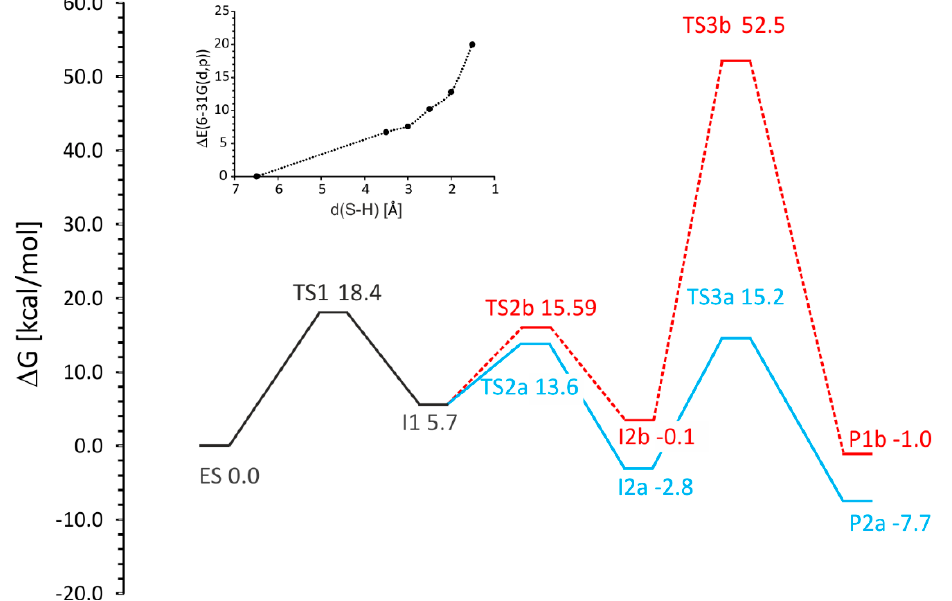
Figure 8. The Gibbs free energy profile obtained for pro( R ) pathway with two variants ( a )—solid blue line and ( b )—dashed red line. The solid black line depicts a common part for both variants ( i.e. , ES-I1). The small panel depicts the distance dependence of electronic energy values from scanning intermediates of a gradual approach of bound toluene towards the Cys493 radical before reaching the enthalpy value of TS1.